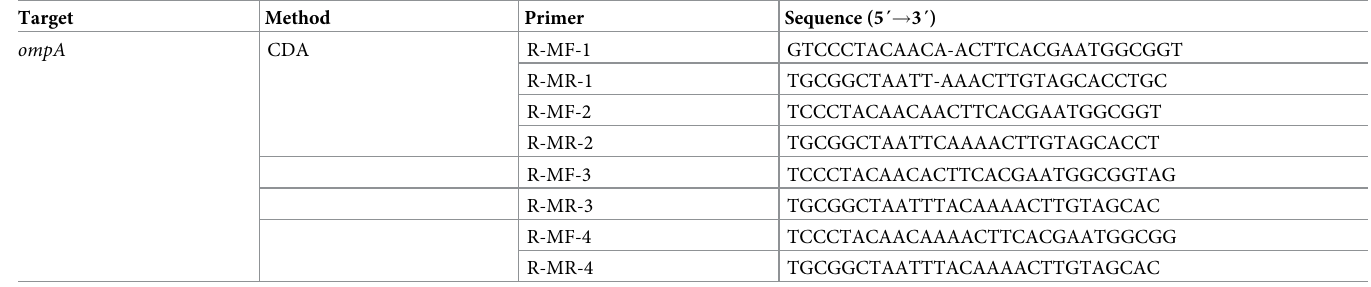
Table 1. Screening of R-CDA basic primer sequences for the mapping genes of Rickettsia raoultii .